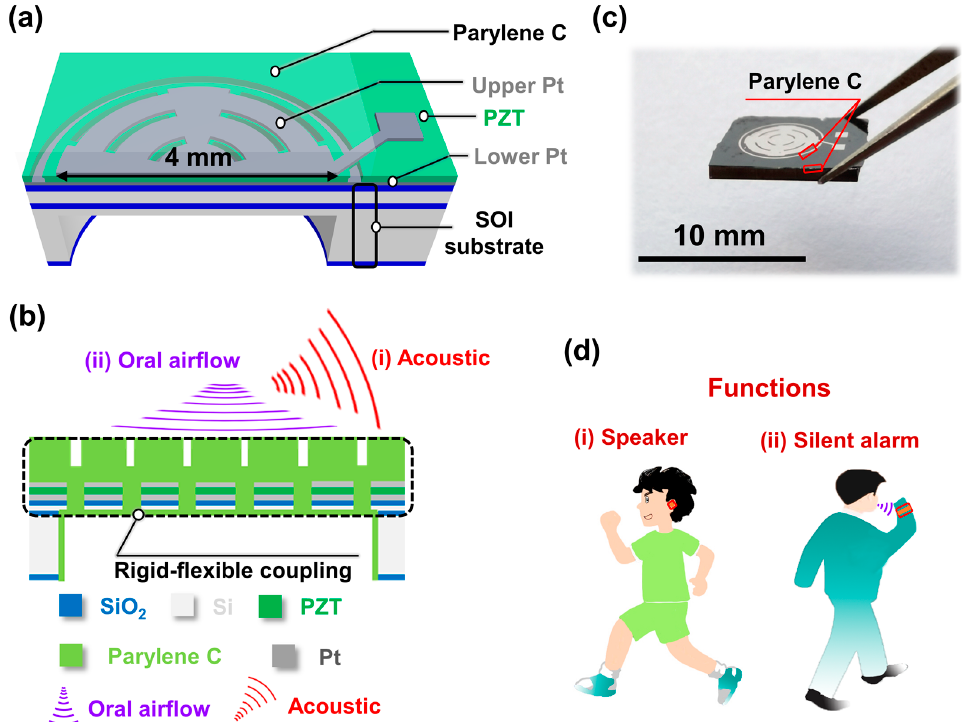
Figure 1. Strategy and design of piezoelectric MEMS speaker combining function of silent alarm. ( a , b ) Strategy and design, (i) Acoustic, (ii) Oral airflow. ( c ) Photographs of chip clamped by tweezers. ( d ) Piezoelectric MEMS speaker (i) combining function of silent alarm (ii).